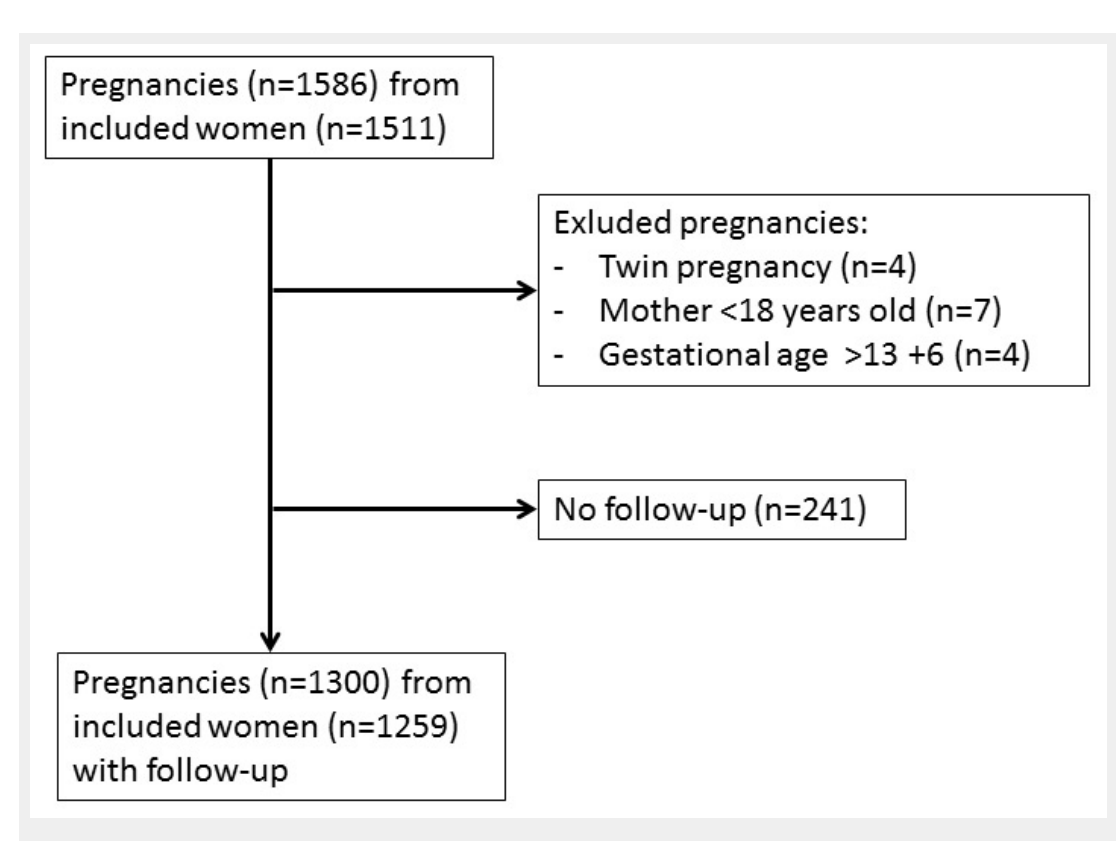
Flow chart of the study. The participating women were subsequently recruited by nine obstetricians based in private